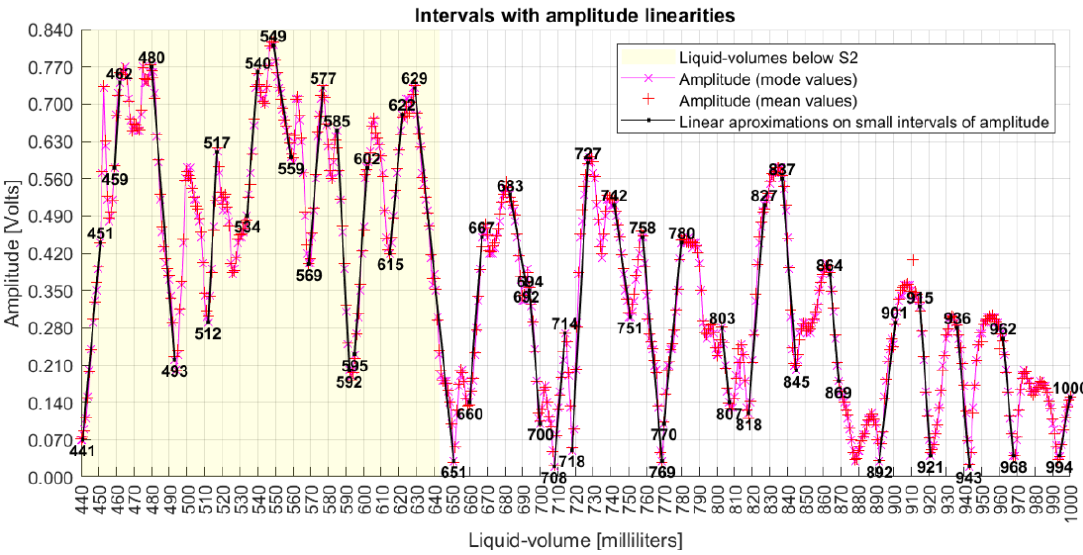
Figure 14. Liquid volumes with linear intervals on the amplitude series.